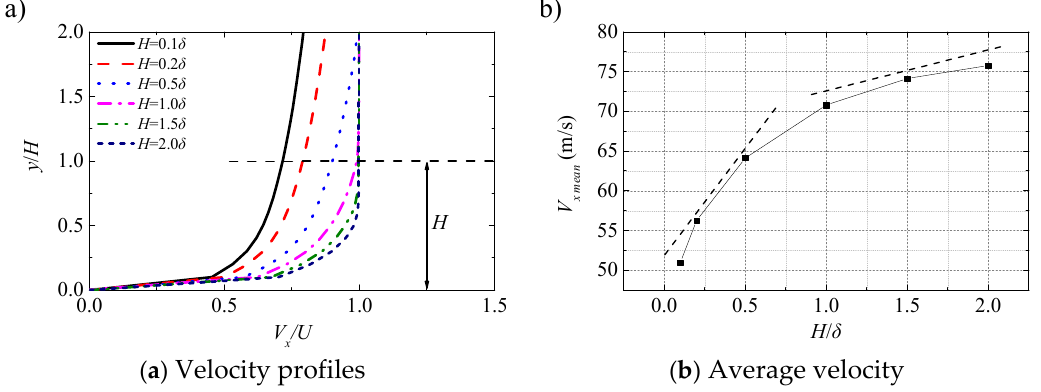
Figure 14. Inflow velocity profiles and average velocity in the VG height range.